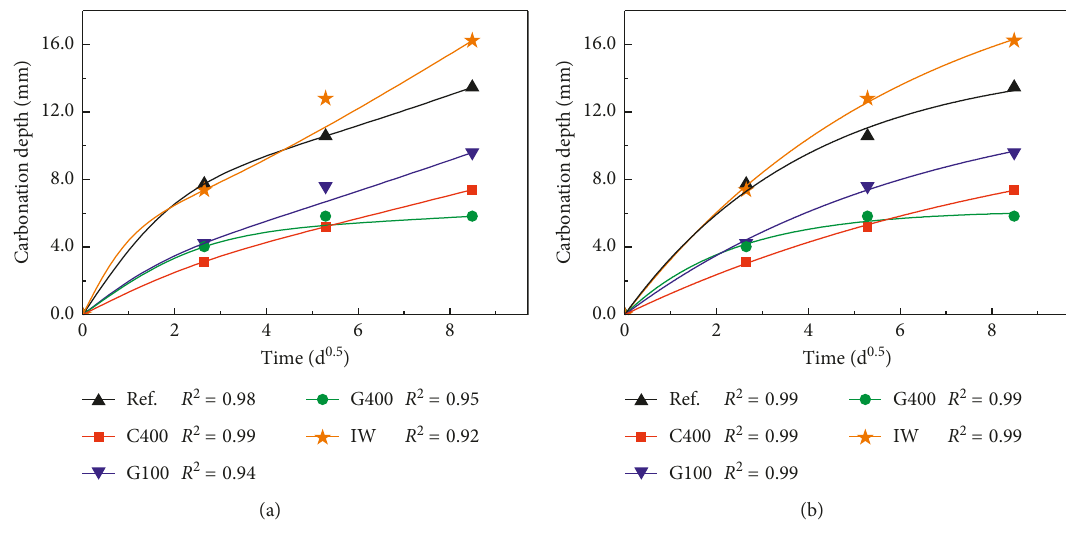
Figure 4: Carbonation depth versus square root of carbonation time. (a) Fitted by (3). (b) Fitted by (4).